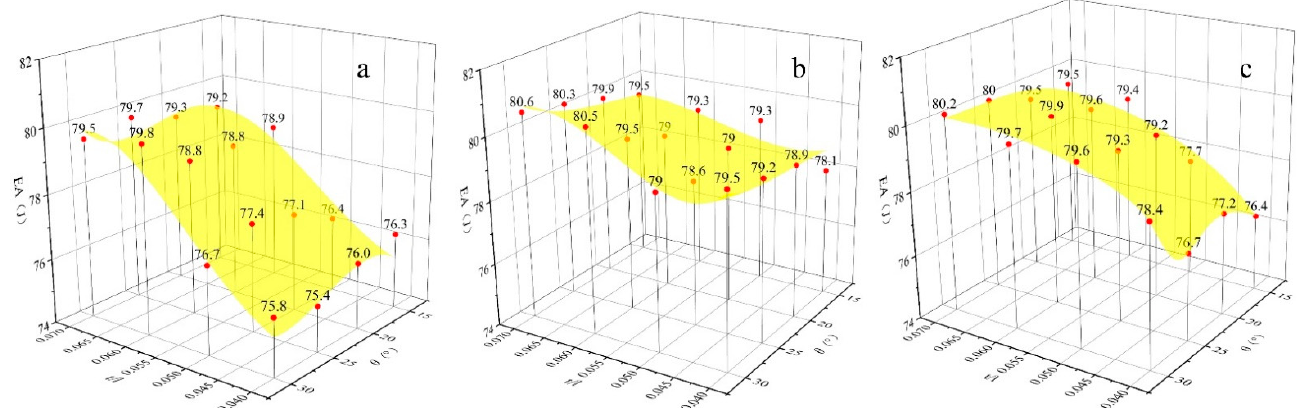
Figure 7. Energy absorption of the honeycomb structure with different Poisson’s ratios at 25 m/s impact speed: ( a ) Poisson’s ratio is positive; ( b ) Poisson’s ratio is negative; ( c ): Poisson’s ratio is zero.